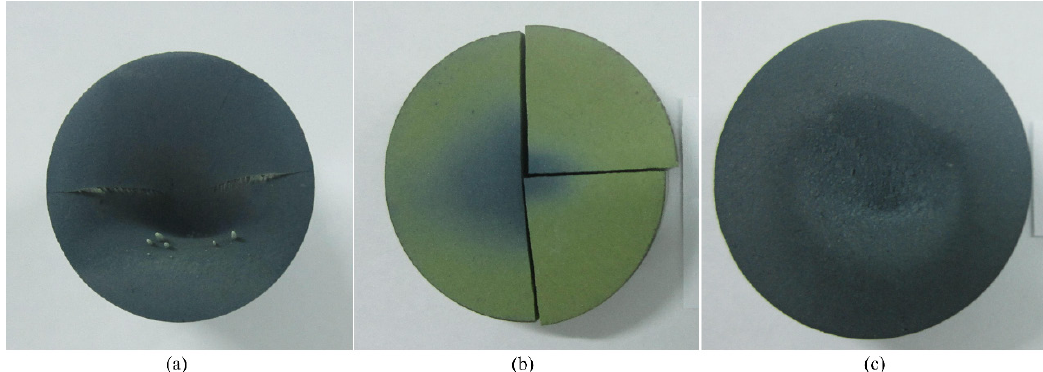
Figure 1. Images of (a) needles, (b) cracks in conventional ITO tablets, and (c) a complete modified ITO tablet.